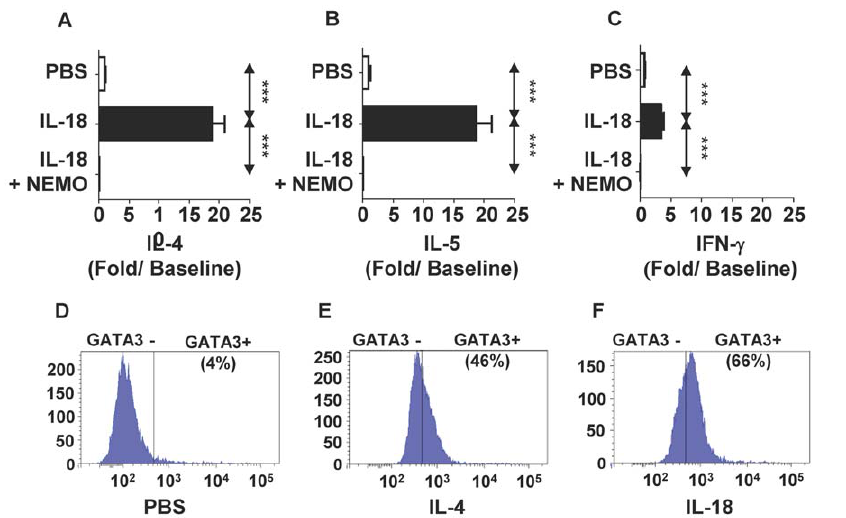
Figure 5. Effect of IL-18 on Th2 differentiation and GATA3 expression in naı ¨ ve CD4 + T-cells. ( A,B,C ). Effect of NEMO peptide on Th2 differentiation. Negatively selected naı¨ve CD3 + CD4 + T-cells were cultured with plate bound anti-CD3 and anti-CD28 with PBS (PBS), IL-18 100 ng/ml (IL-18), IL-18 100 ng/ml and 10 m M NEMO Binding Domain Binding Peptide (IL-18 + NEMO) for the initial culture period. The cells were washed and restimulated, and secretion of IL-4 ( A ), IL-5 ( B ) and IFN- c ( C ) were quantified. The data was expressed as fold increase compared to cells cultured with PBS. ( D,E,F ). GATA3 expression in T-cells. Negatively selected naı¨ve CD3 + CD4 + T-cells were cultured with plate bound anti-CD3 and anti-CD28 in the presence of PBS ( D ), IL-4 ( E ) or IL-18 ( F ) for 7 days. GATA3 expression was measured by flow cytometric analysis.